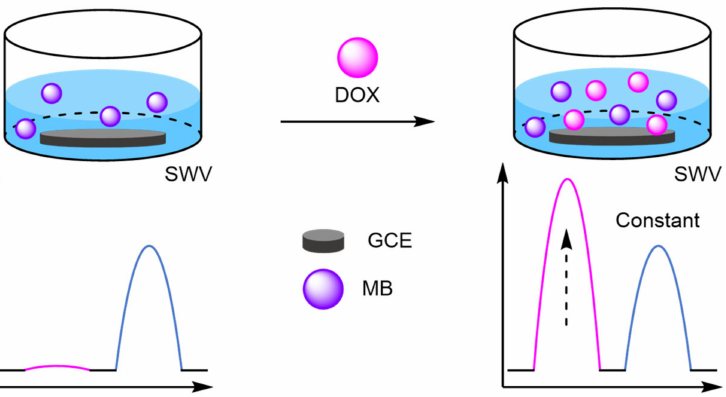
Figure 45. Schematic representation of an unmodified electrode for the detection of doxoru- bicin